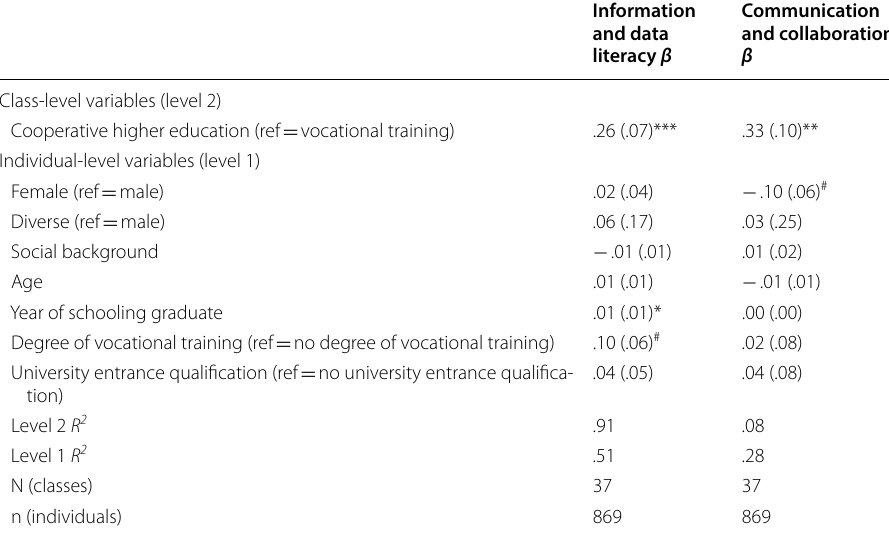
Table 4 Results of multilevel analysis of the digital competences in formation and data literacy and communication and